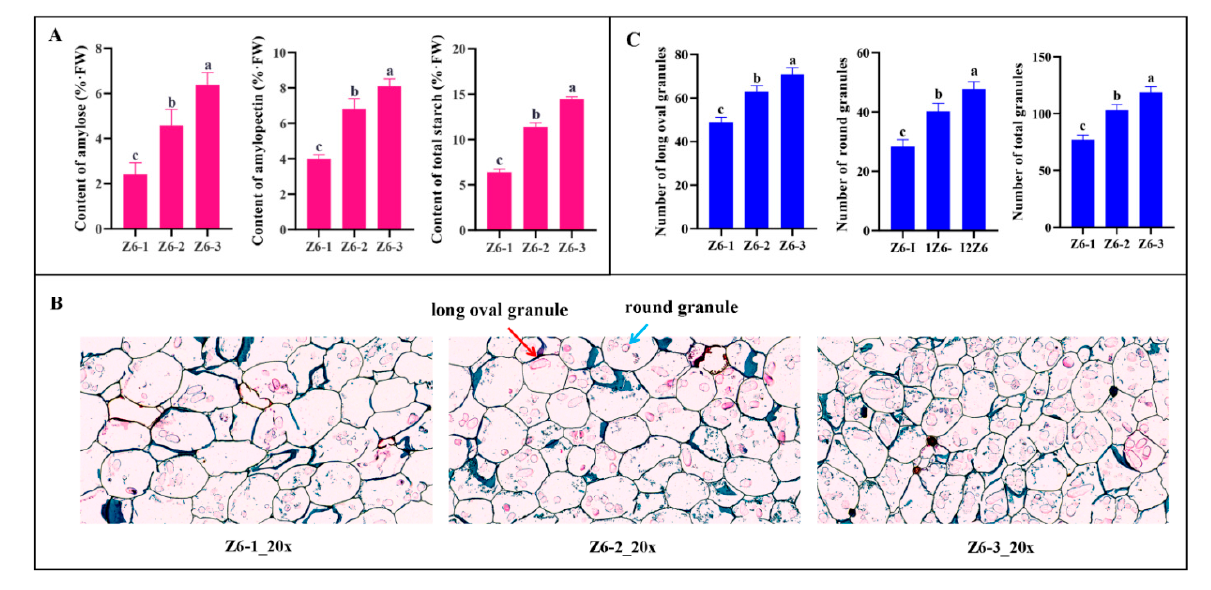
Figure 1. Starch characteristics of lotus rhizome. ( A ) Content of amylose, amylopectin, and starch of Z6-1, Z6-2 and Z6-3. ( B ) The starch granules in paraffin internodes were observed under microscope of Z6-1, Z6-2 and Z6-3. The red arrow represents long oval granule, blue arrow represents round granule. ( C ) Statistics of starch granules of Z6-1, Z6-2 and Z6-3. Each sample used to determinate of amylose, amylopectin and total starch were set for three biological replicates. Ten paraffin section pictures were used to counted the number of starch granules. Error bars show SD from three biological replicates. The ‘a’, ‘b’ and ‘c’ above the histogram indicated the statistical significance at the level of 0.05 ( p < 0.05).